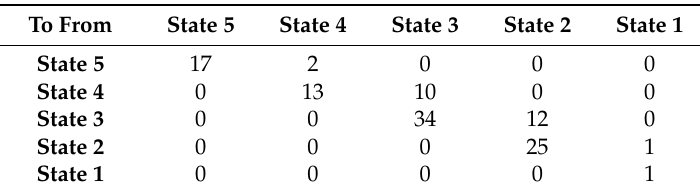
Table 5. Transition of transformer states for the year